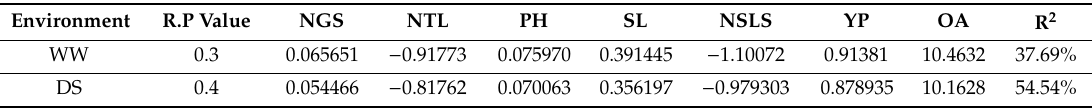
Table 4. Thousand kernel weight (TKW) variability estimation model obtained by ridge regression along with estimated regression and R square